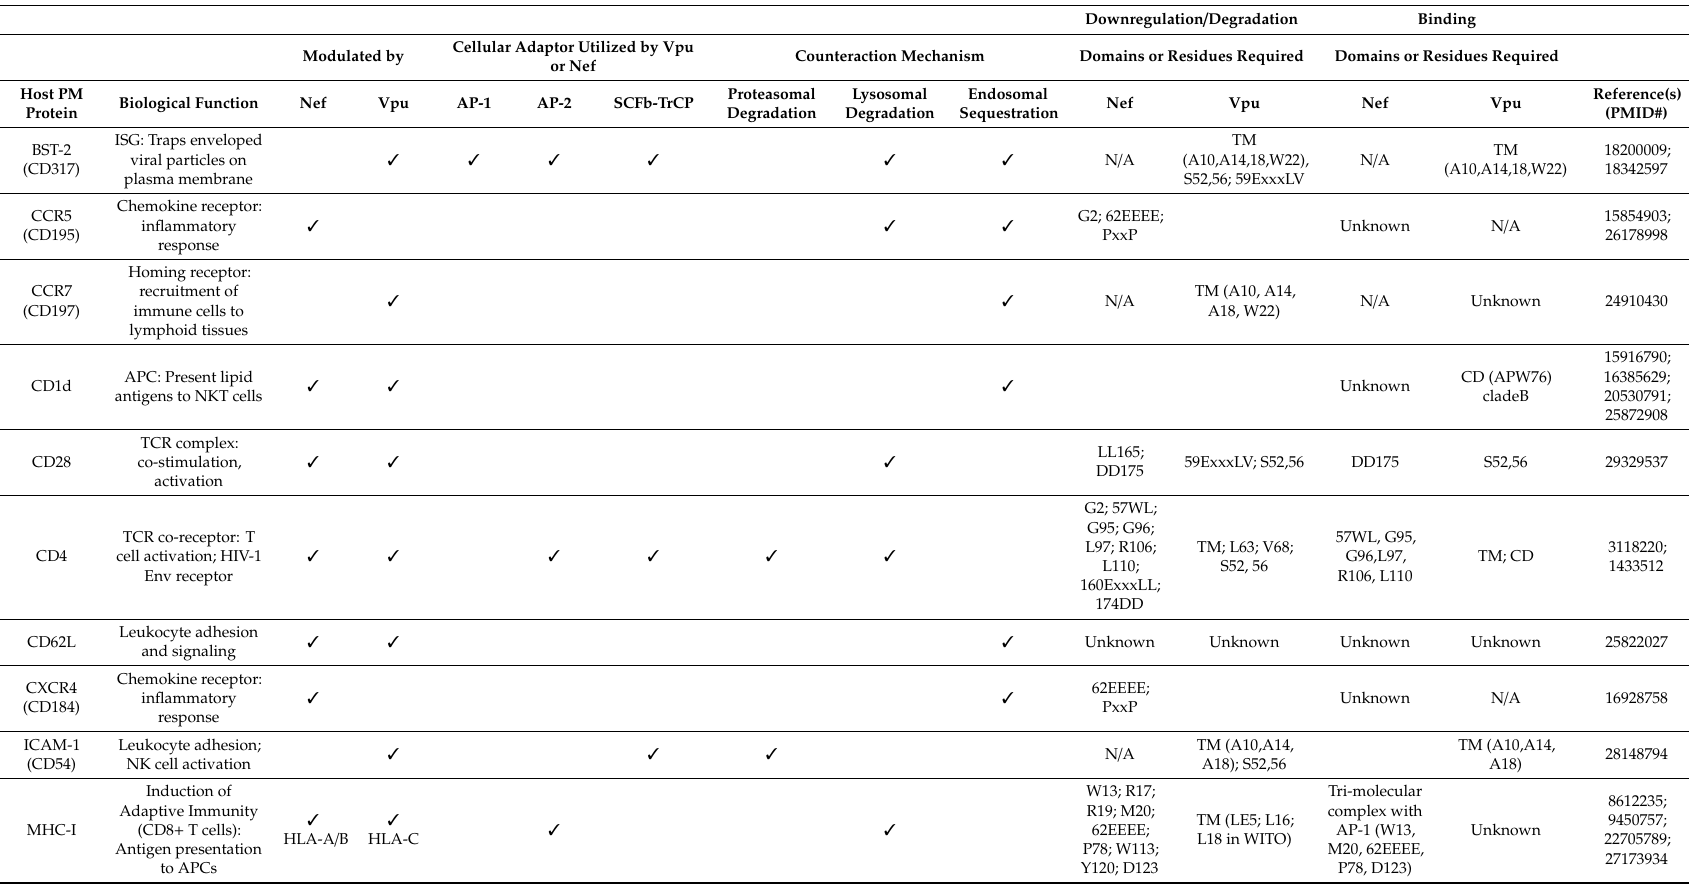
Table 1. Partial Summary of Plasma Membrane Proteins Modulated by HIV-1 Vpu and Nef. Downregulation / Degradation Binding Cellular Adaptor Utilized by Vpu or Nef Counteraction Mechanism Domains or Residues Required Domains or Residues